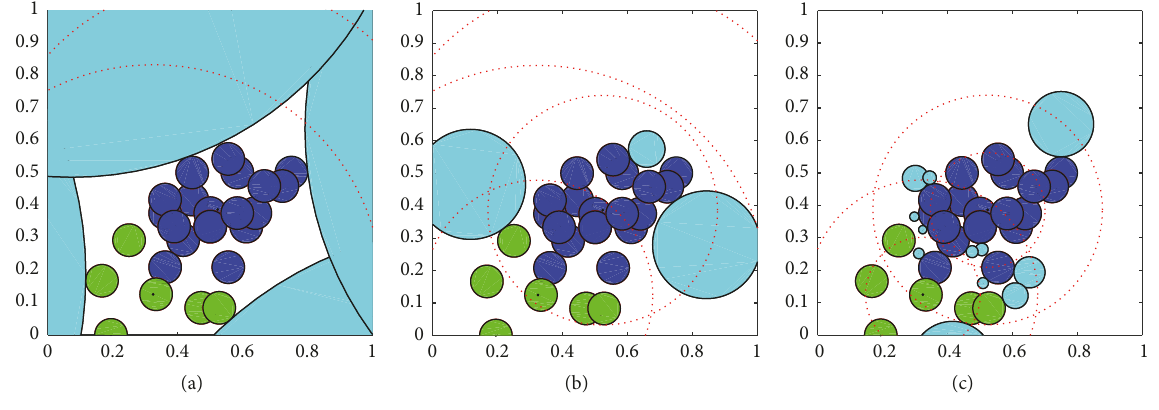
Figure 10: Limited scopes and generations of candidate